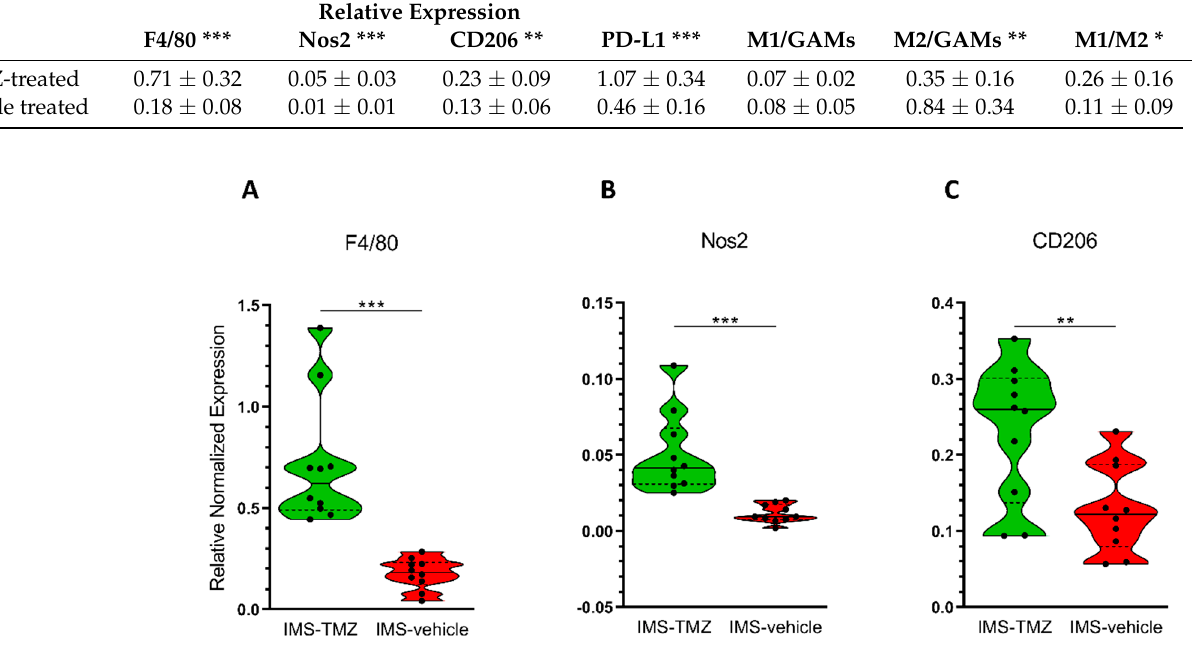
Figure 2. Violin plot for estimation of different cell populations in IMS-TMZ-treated GL261 GB and control mice, for comparisons of ( A ) global GAMs population through F4/80 expression level analysis ( p = 0.0004), ( B ) M1 macrophage subtype population through Nos2 expression level analysis ( p = 0.001), and ( C ) M2 macrophage subtype population through CD206 expression level analysis ( p = 0.009). Data are the mean ± S.D. and significant differences between groups are indicated by asterisks (*** p ≤ 0.001, ** p < 0.005), n = 10 for each group. Solid horizontal line in violin plots indicates median and the dashed lines indicate 1st and 3rd quartiles. Note that graphs are shown with different “y” scaling for better appreciation of data